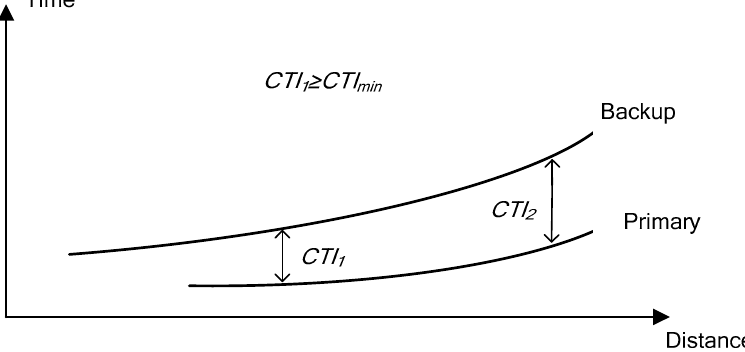
Figure 2. Coordination between primary and back-up relays keeping a minimum coordination time interval (CTI).